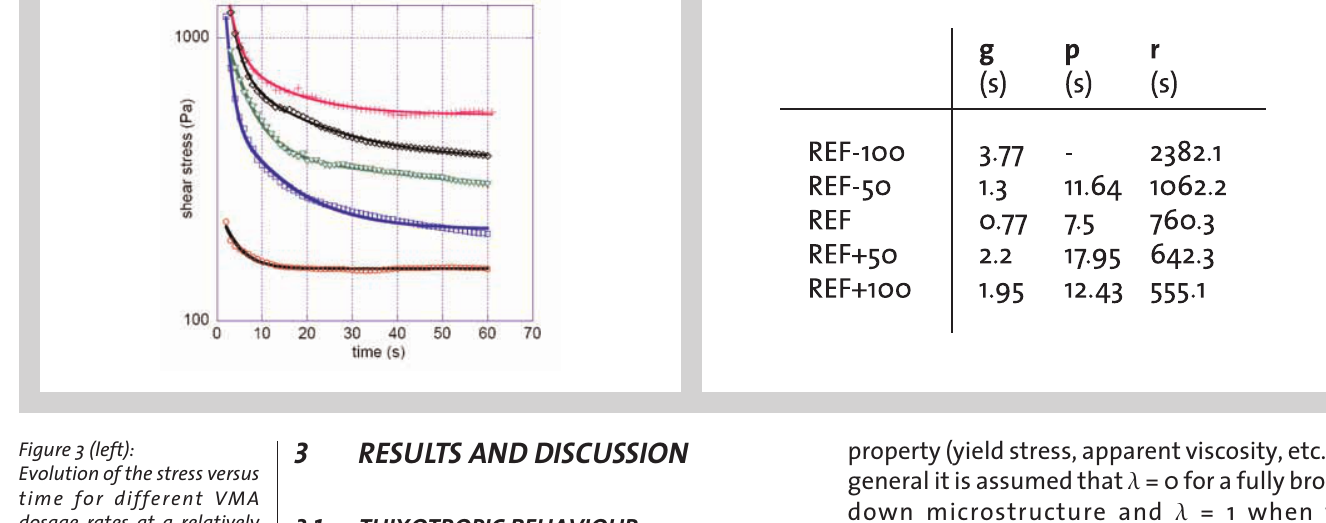
Figure 3 (left): Evolution of the stress versus time for different VMA dosage rates at a relatively high shear rate (200 s-1), rep- resenting the microstructure break down. The continuous lines correspond to the best fit with the sum of two expo- nentials